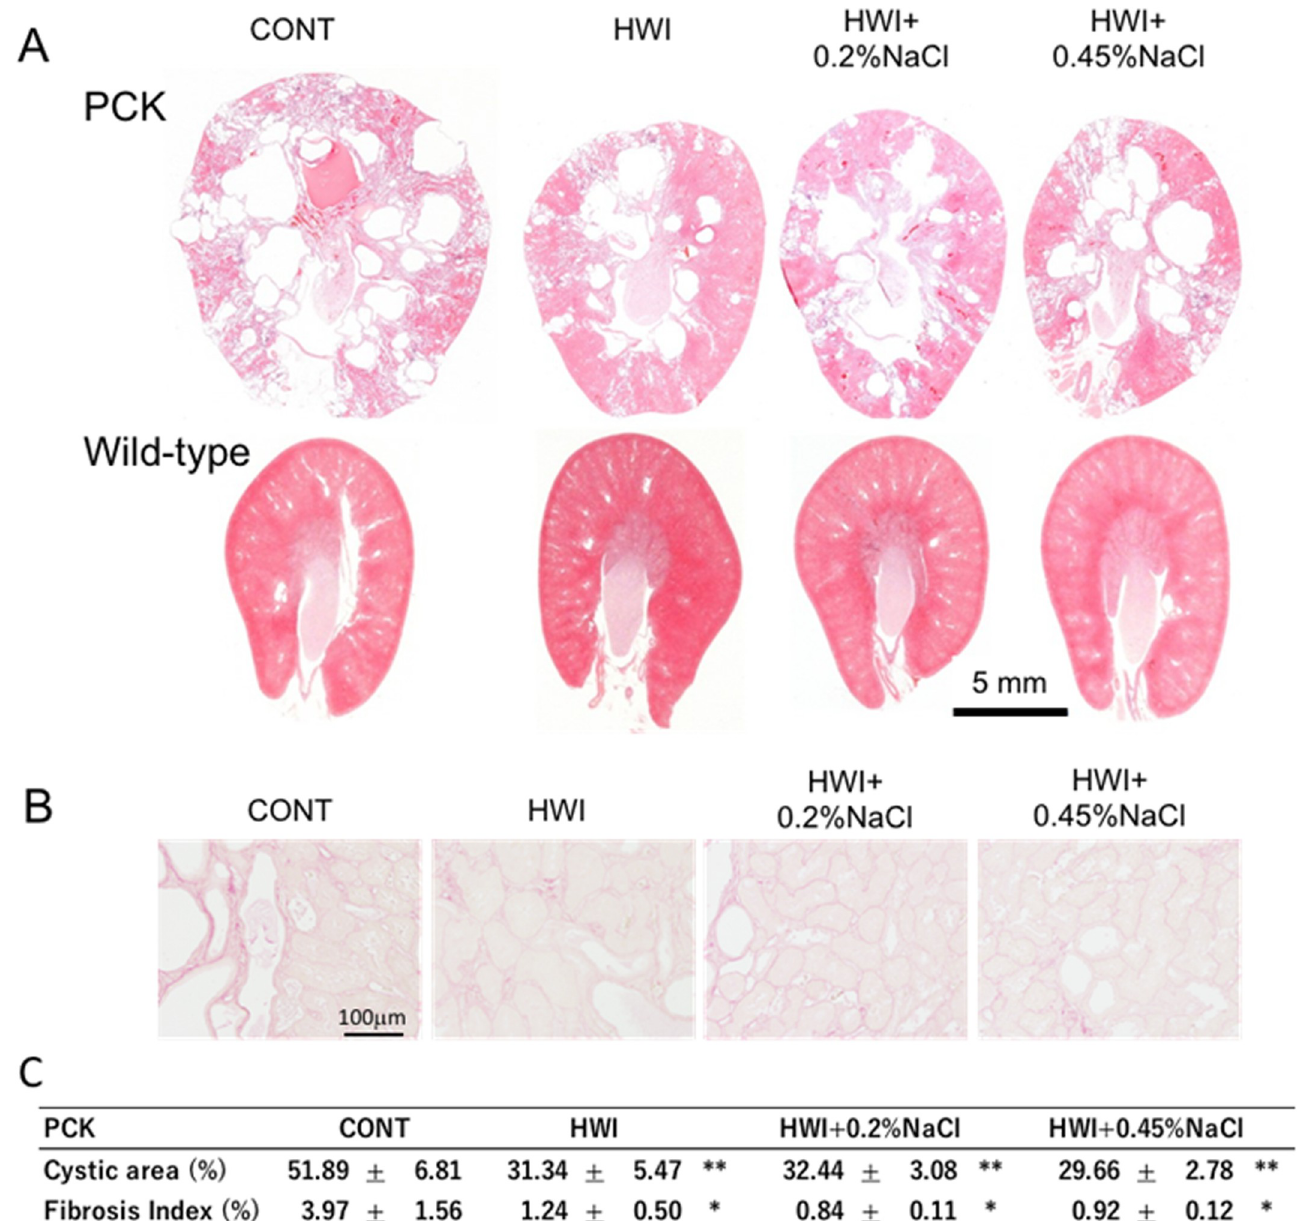
Fig 4. Effect of HWI and NaCl overload on renal histology, cystic area, and fibrosis index. (A) H&E-stained kidney sections of PCK and wild-type rats. (B) Picrosirius red-stained kidney sections of PCK rats. (C) Cystic area and fibrosis index obtained from H&E-stained and picrosirius red-stained kidney sections, respectively, in each group. CONT, distilled water group; HWI, high water intake group (5% glucose); HWI+0.2%NaCl, high water intake with 0.2% NaCl group; HWI+0.45%NaCl, high water intake with 0.45% NaCl group. Comparison between CONT and treated groups: � , P < 0.05; �� , P < 0.01. https://doi.org/10.1371/journal.pone.0207461.g004 except between HWI+0.45%NaCl (4.40 ± 0.10 mEq/L, P < 0.05) and CONT (5.07 ± 0.15 mEq/ L). Total urine inorganic phosphorus excretion (U-IP) during the experimental period and serum inorganic phosphorus concentration (S-IP). In PCK rats, the total amount of U-IP was higher only in HWI+0.45%NaCl (31.3 ± 2.8 mg, P = 0.052) compared with CONT